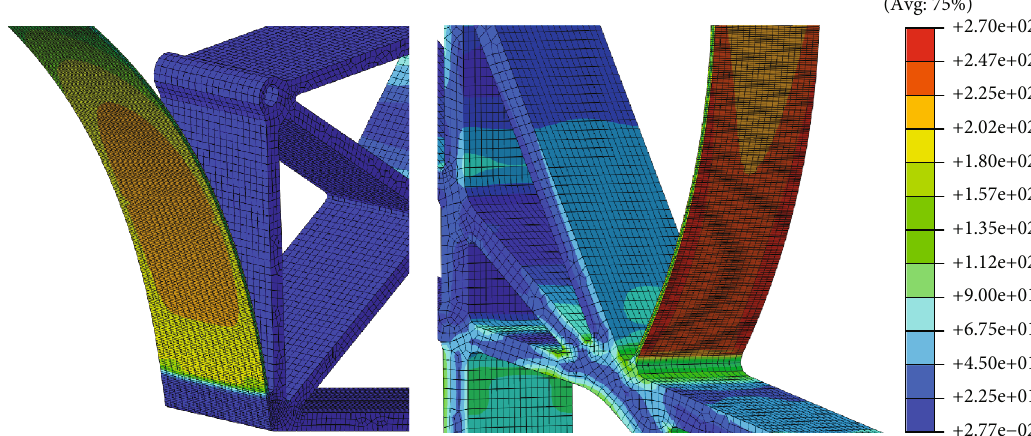
Figure 13: Root rib: detail of the most stressed regions under limit